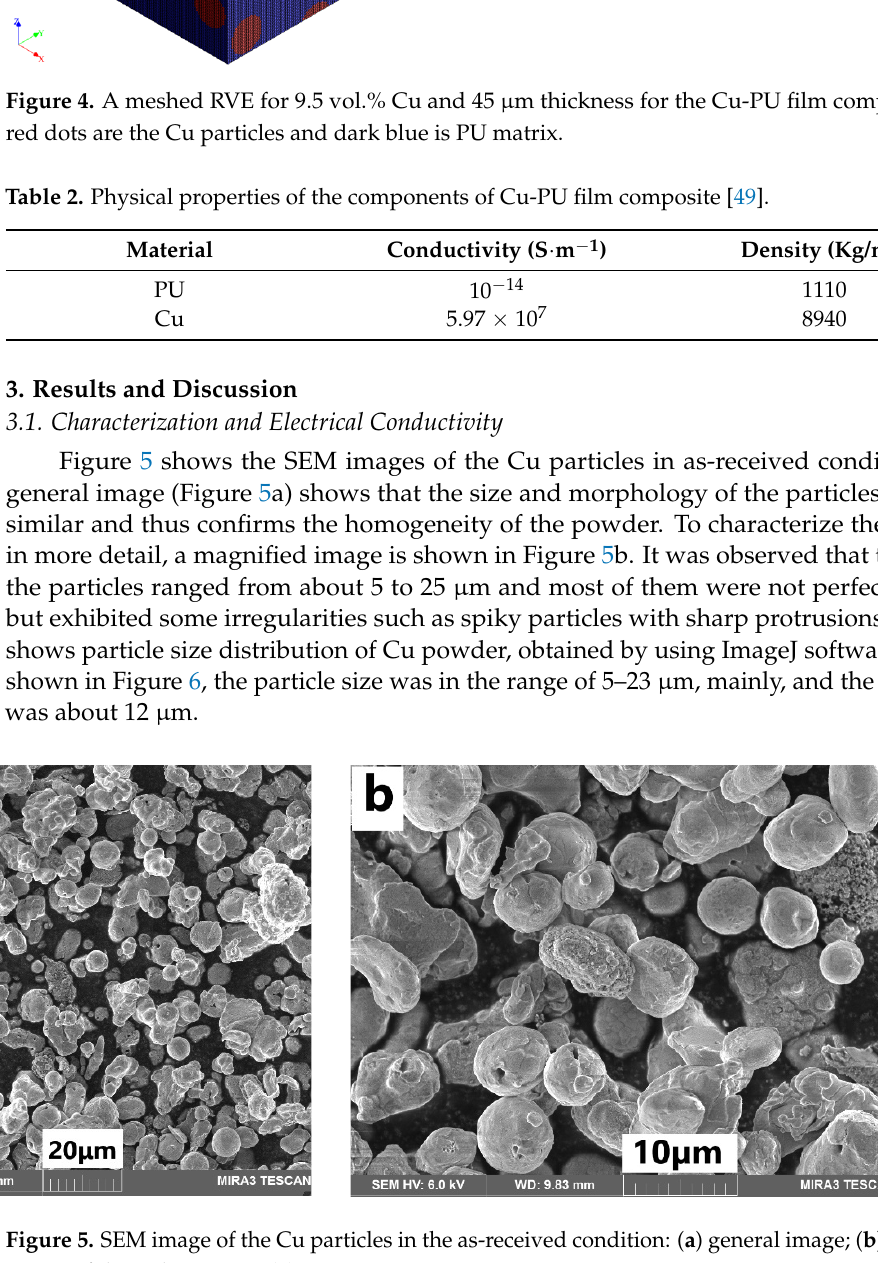
Figure 6. Number of particles vs particle size histogram showing the distribution of Cu powder. The numbers in brackets on the x-axis denotes the size range in microns. The particle size distribu- tion was based on the image evaluation of 113 particles. Particles of Cu were added to PU in different concentrations, from 0.55 vol.% to 20 vol.%, thus forming different Cu-PU composites as shown in the optical microscopy (OM) images of Figure 7. The distribution of particles across the composites was very homoge- neous, although with some slight local agglomeration for concentrations of 6.6 vol.% and higher, which was similar to the observation from other authors [41,42]. As the concentra- tion of Cu particles increased from 0.55 vol.% (Figure 7a) to 20 vol.% (Figure 7h), the rel- ative distance between particles decreased, from around 200 μ m to 4 μ m, respectively. This could indicate that the density of Cu in the composites witnessed an increment pro- portionate to the higher filler content.